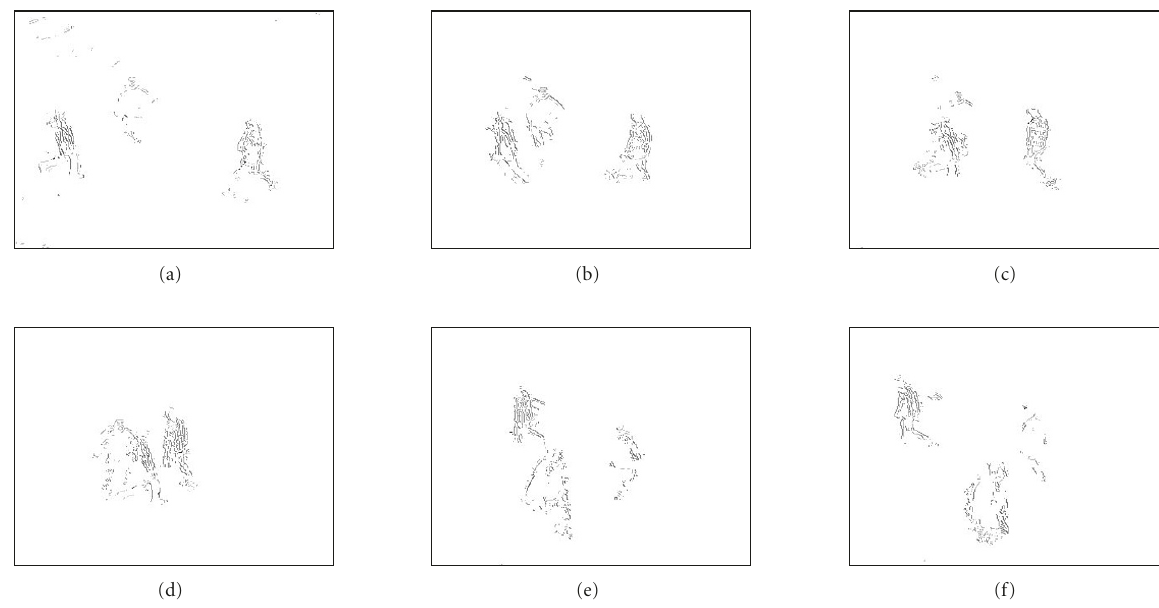
Figure 7: Moving objects in the video sequence given in Figure 6. All the three pedestrians in the video sequence are well captured and di ff erent directions are shown in di ff erent gray levels. We can also see that the static background is correctly detected to be not moving. We show motion detected at (a) and (b) the beginning (c) and (d) while crossing each other (e) and (f) after temporary